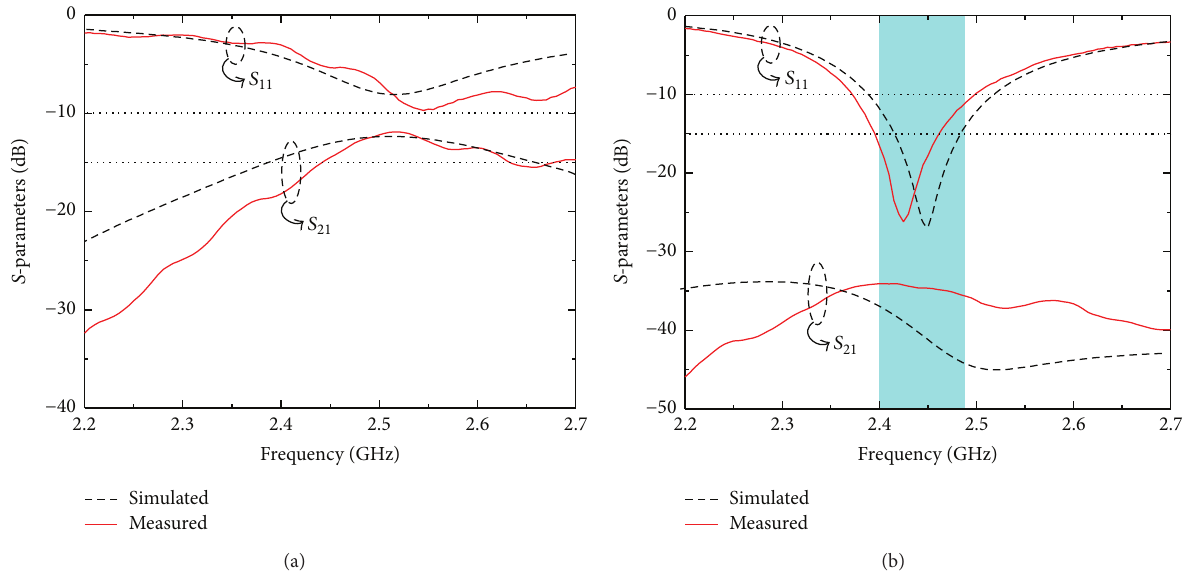
Figure 14: Simulated and measured 𝑆 -parameters of (a) initial MIMO antenna and (b) final MIMO antenna.